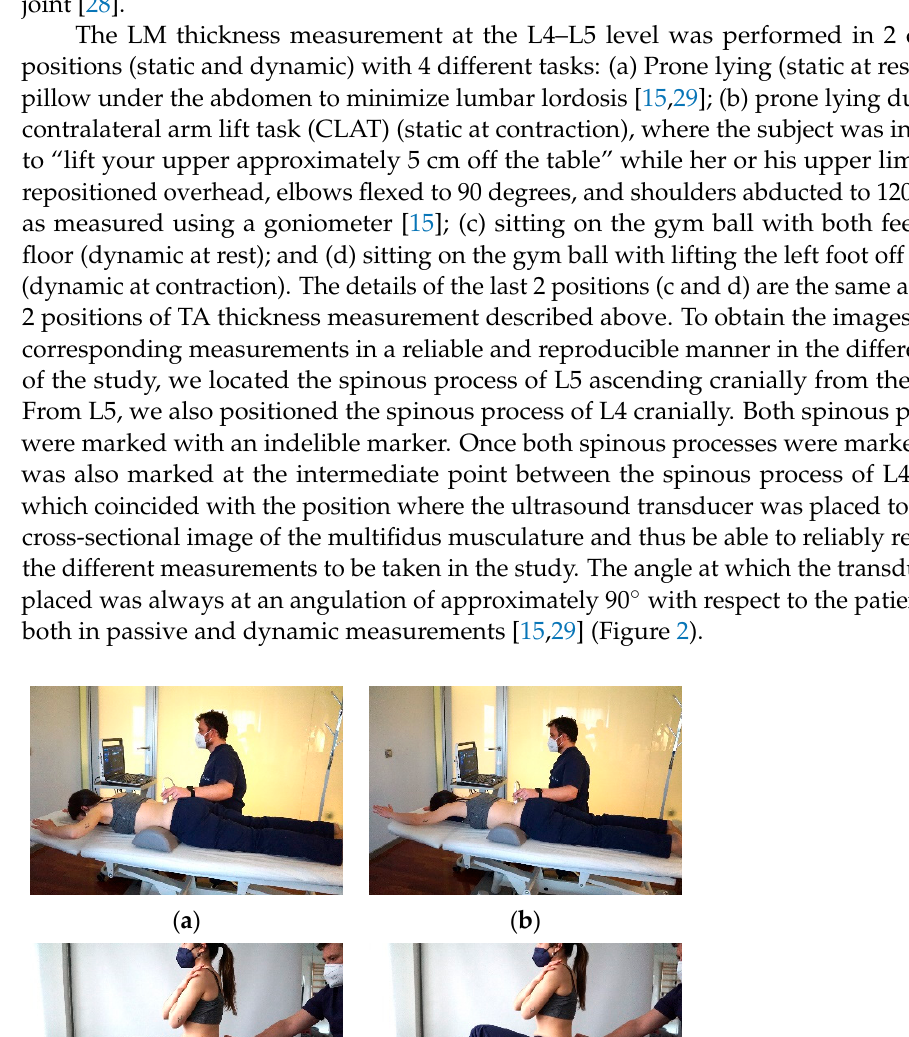
5 of 13 Figure 1. Images representing the positions used to measure TA muscle thickness at rest and con- traction in different positions to obtain the CR ( a ) Transversus abdominis (TA) thickness measure-